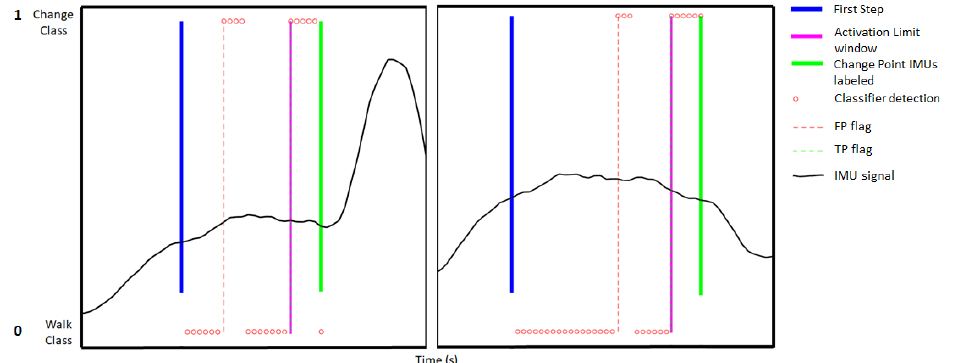
Figure 5. The pseudo-online metrics were evaluated from the start of the labeled start gait in the IMUs signal (solid blue) until the change speed point (solid green). In red dots the decision of the classifier based on the established metrics was marked according to the detected brain activity each 0.2 s. According to the metric, once an activation was detected, if it was detected between the blue line and the pink line, it would be counted as a FP. On the contrary, if it was detected between the pink line and the green line, it would be counted as a TP. On the left of the image appears a repetition showing an increment with a FP and a correct activation. On the right of the image appears a decreasing repetition with a FP and a correct